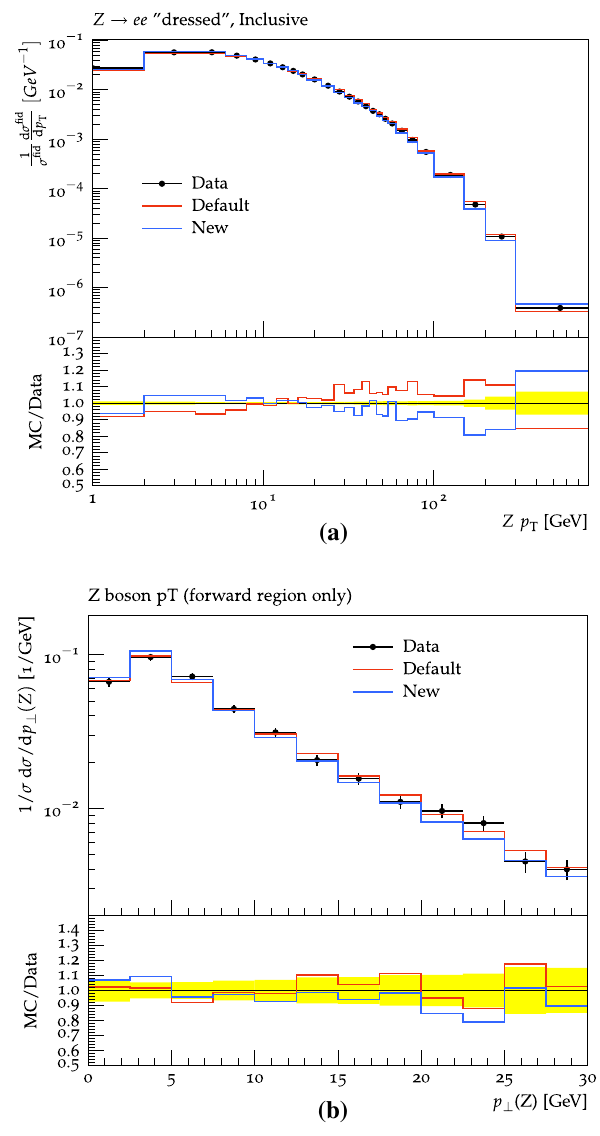
Fig. 11 Comparison between the new and old schemes for the γ ∗ / Z 0 p ⊥ spectrum measured by a ATLAS for pp collisions at 7 TeV [44,46], b D0 for pp collisions at 1.96 TeV